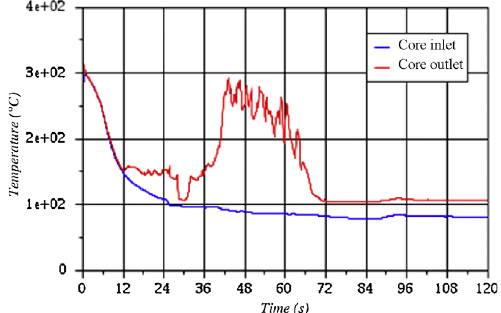
Fig. 17. Primary temperature ( °